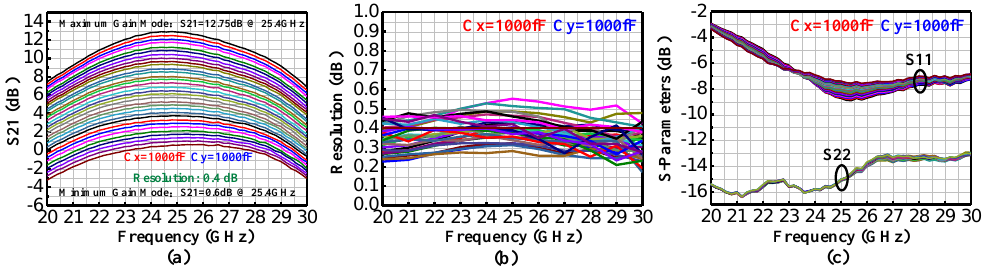
Figure 7. Based on C x = 1000 fF, C y = 1000 fF (Ctr1 = 1 V, Ctr2 = 1 V): ( a ) measured 32 gain states versus frequency and ( b ) its corresponding 31 gain resolutions versus frequency; ( c ) measured S11 and S22 versus frequency at 32 control states.